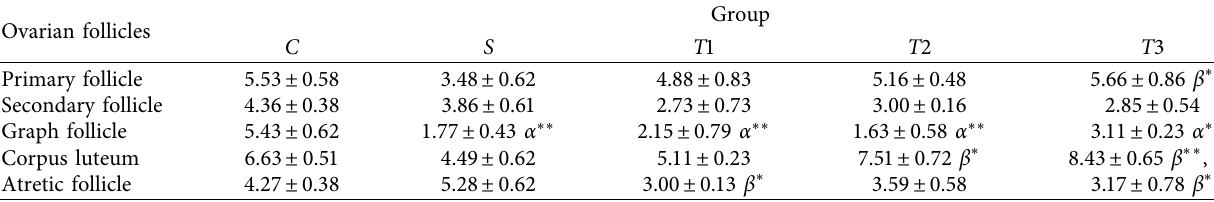
Table 2: Changes in animal ovarian cells in the experimental groups.